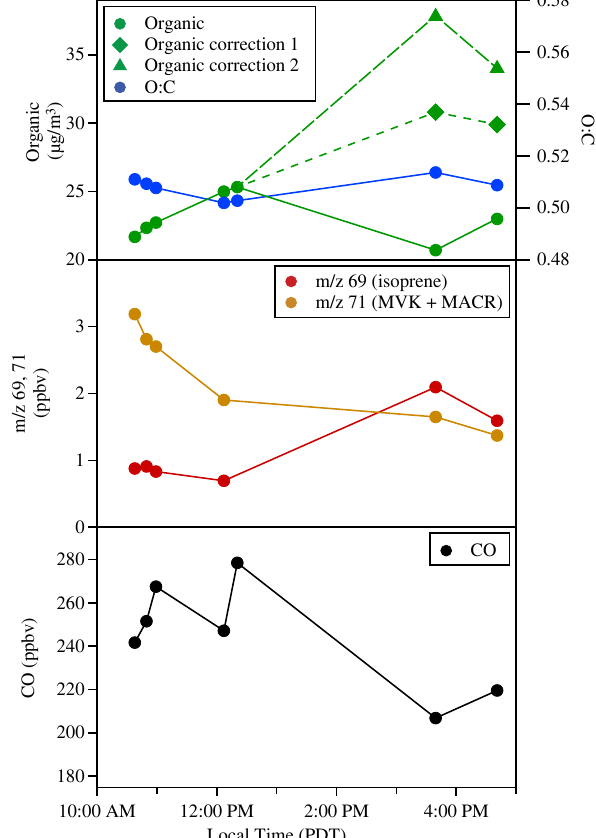
Fig. 5. Evolution of the average concentrations of OA, CO, and bio- genic tracers within the mixed anthropogenic/biogenic plume on the 28 June flights. Each point is the average of approximately 170 s of data centered about the point of maximum OA for each pass of the G-1 through the plume (indicated by the pink line in Fig. 4). Lines are shown to guide the